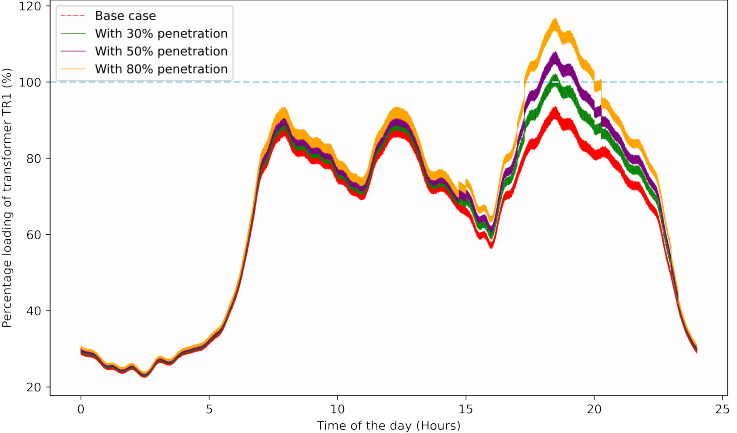
Figure 6. Percentage loading of transformer TR1 for different levels of EV